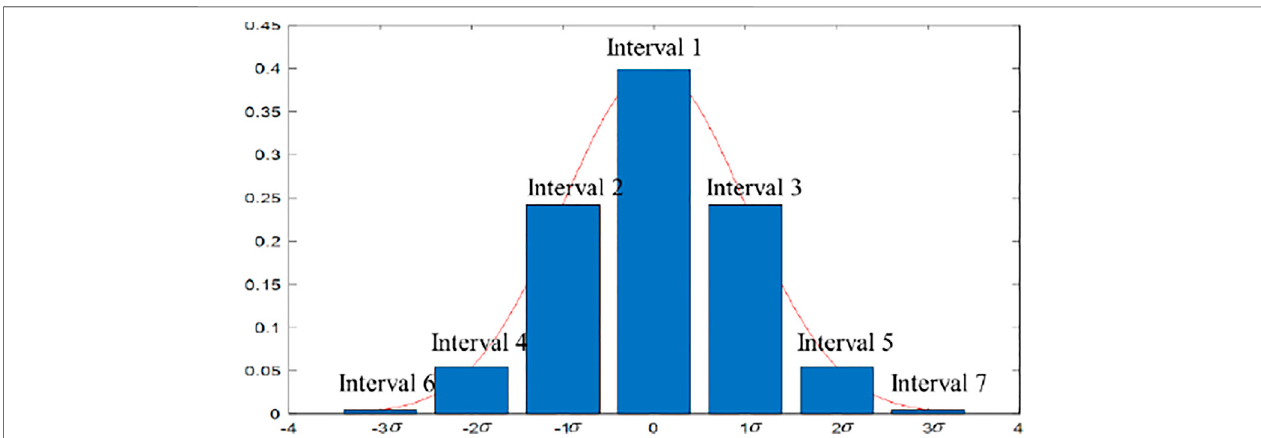
FIGURE 2 | Wind out power/load forecast